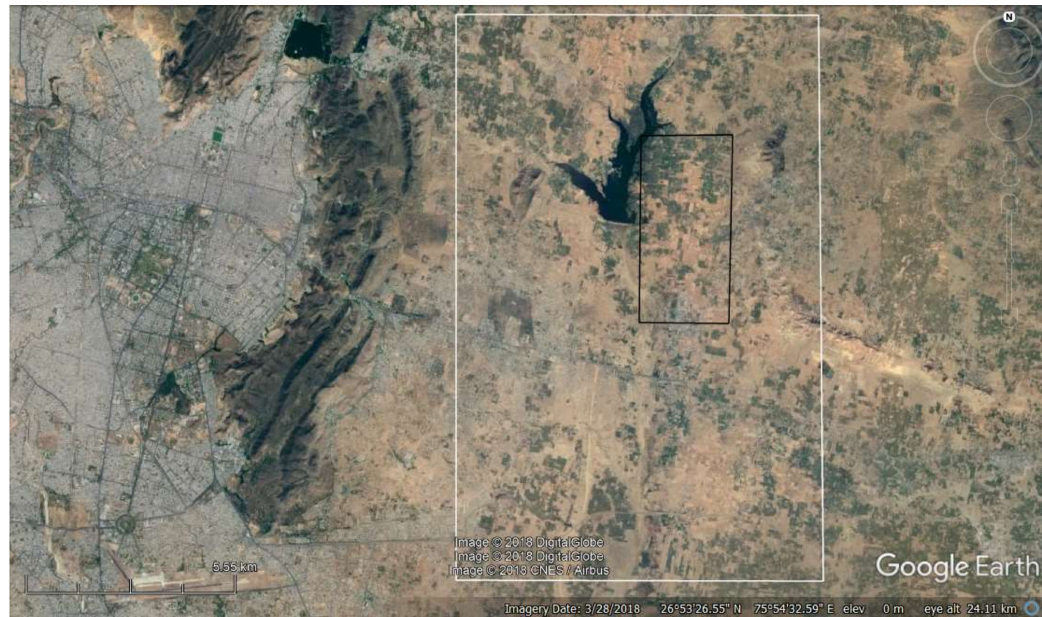
Figure 2. Imagery of the test site, to the east of Jaipur which is visible at the left-hand side of the Figure. The study focused on the region contained within the white box with the area inside the black box used only for the purposes of training the classifications. The image backdrop was acquired in January